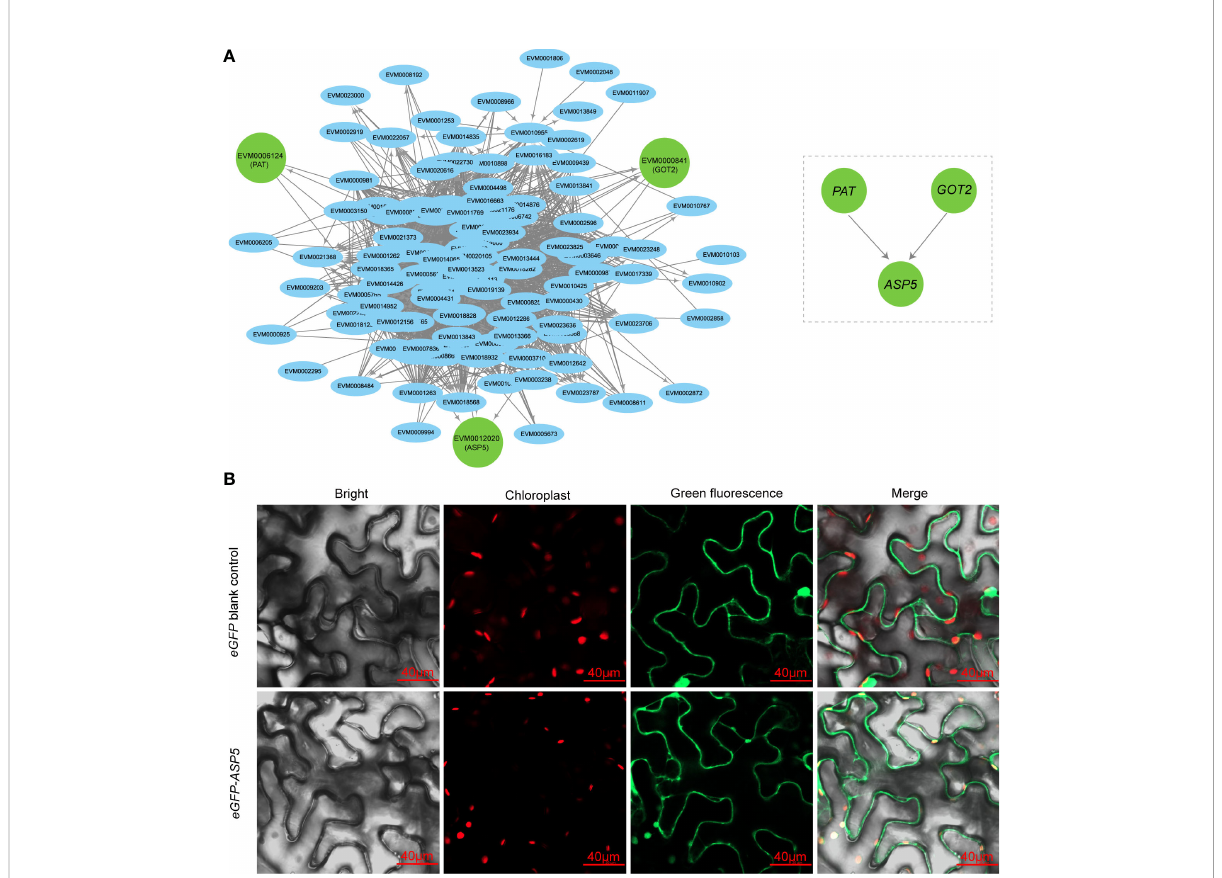
FIGURE 3 Subcellular localization of hub genes. (A) Hub genes of the aromatic amino acid biosynthesis pathway in the brown module, as represented by node and edge graphs. (B) Subcellular localization of ASP5 . The eGFP - ASP5 fusion plasmid was transiently expressed in Nicotiana benthamiana leaves. Plasmid only contain eGFP was also transiently expressed as